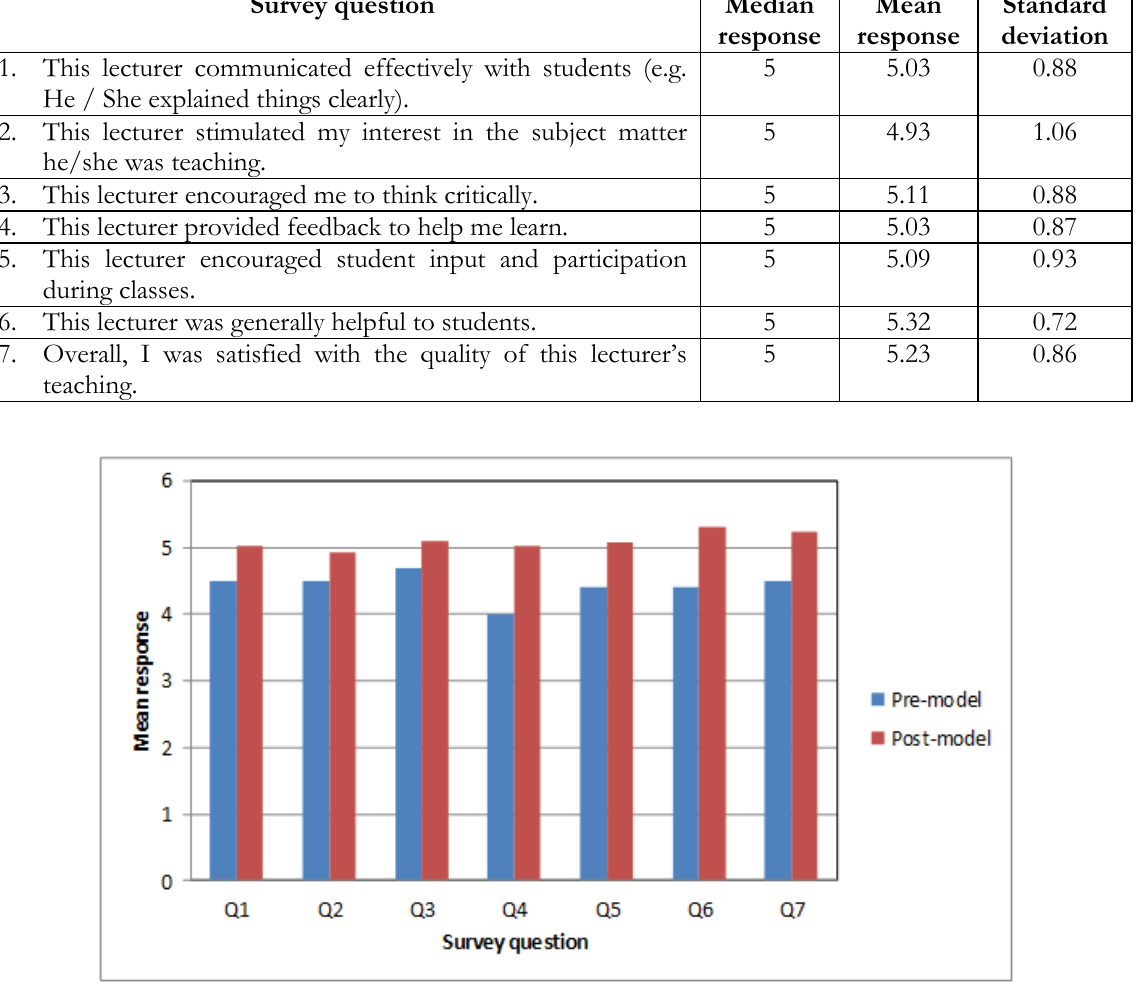
Table 2: Descriptive statistics of survey responses Survey question Median